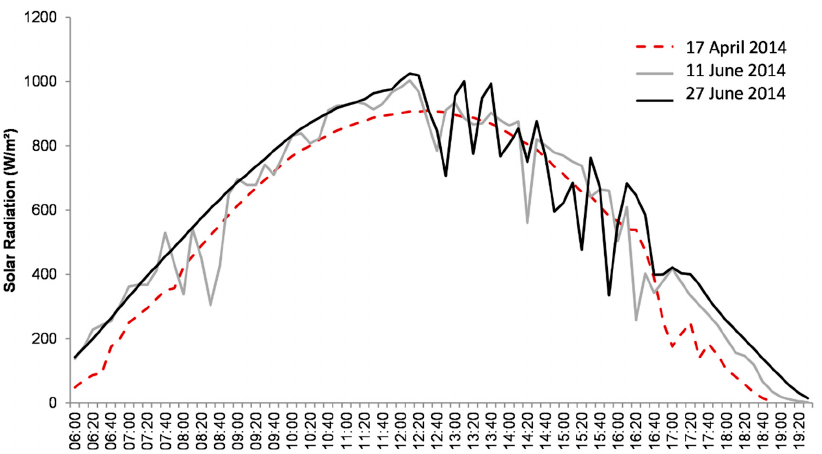
Figure 4. Example of daily solar radiation data from in situ meteorological flux tower.